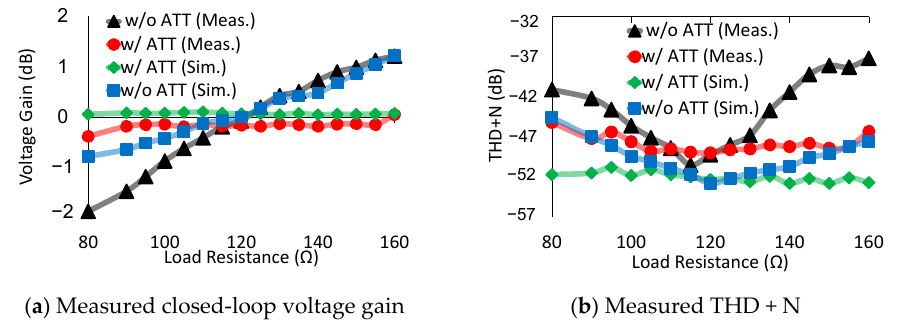
Figure 13. Simulated and measured closed-loop voltage gain (A V ) and THD + N of the hybrid line driver against load resistance variations at F IN = 40MHz and output swing of 2.8 V PP differential.